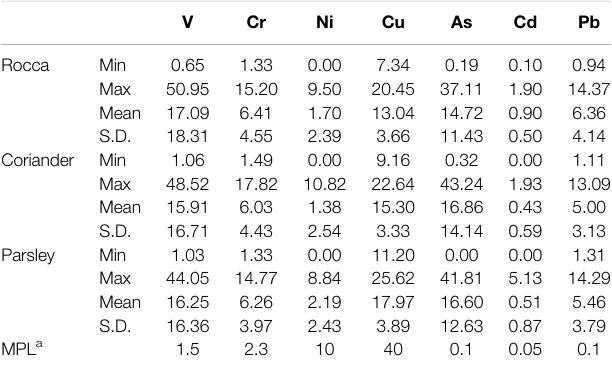
TABLE 1 | Metal(oid) concentrations (mg/kg dry weight) in the vegetable (rocca, coriander, and parsley)